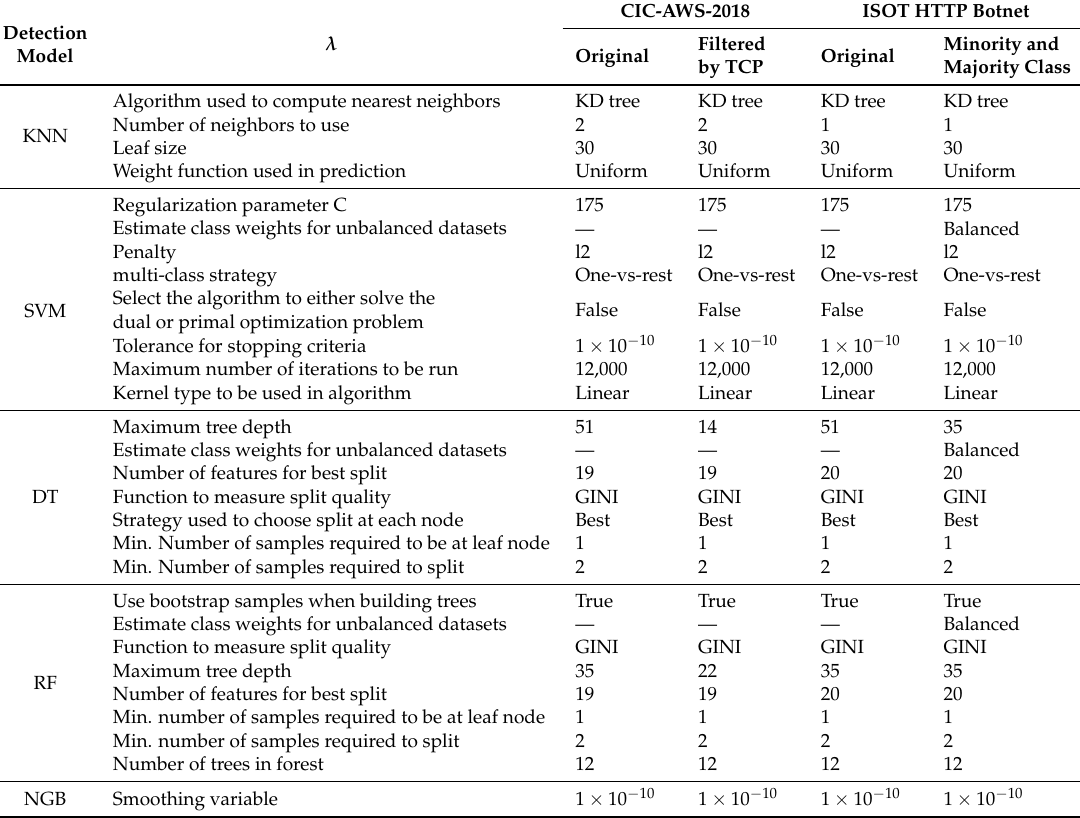
Table A1. Algorithms with Their Initial Hyperparameters λ